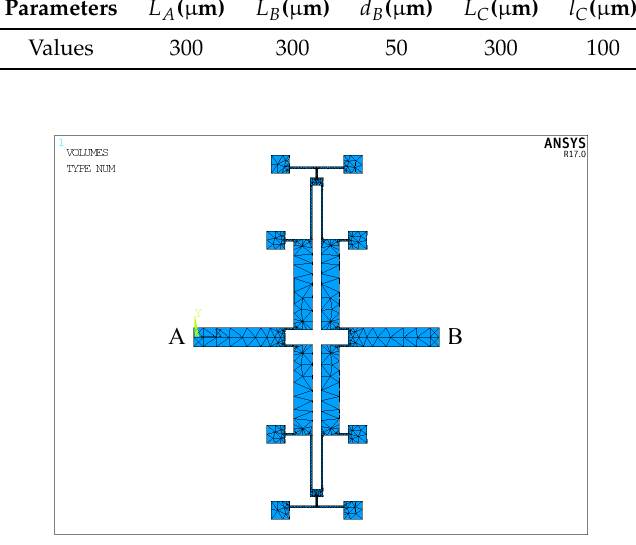
Figure 7. The finite element model of the lever coupling